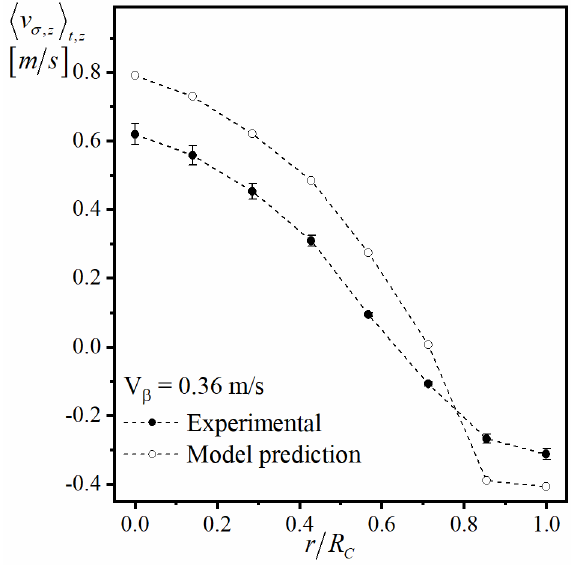
(cid:10) (cid:11) = 0.36 m/s for a fluidized bed of D V β 0.36 m s V = for a fluidized bed of 0 β 0